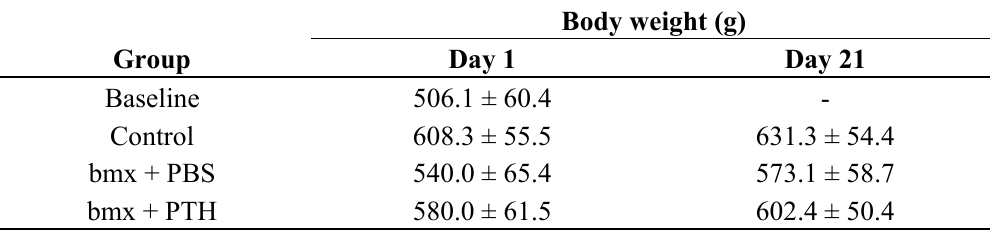
Table 1. Animal body weight. Data are presented as mean ± SD. n = 8 for Control; n = 12 for all other